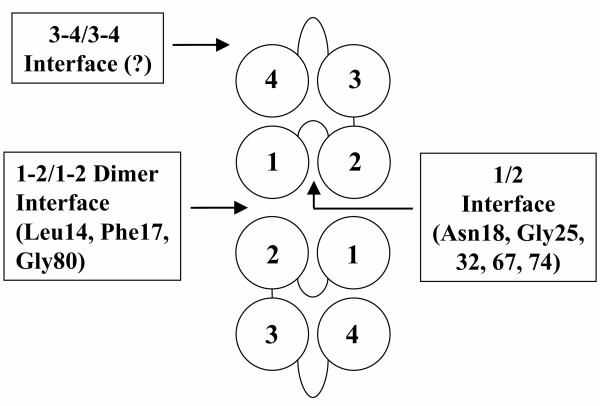
A model of the organization of a tetraspanin dimer. Two interfaces, the intramolecular TM1/TM2 and intermolecular TM1-TM2/TM1-TM2, have been analysed in this work. A third interface, intermolecular TM3-TM4/TM3-TM4, is predicted.